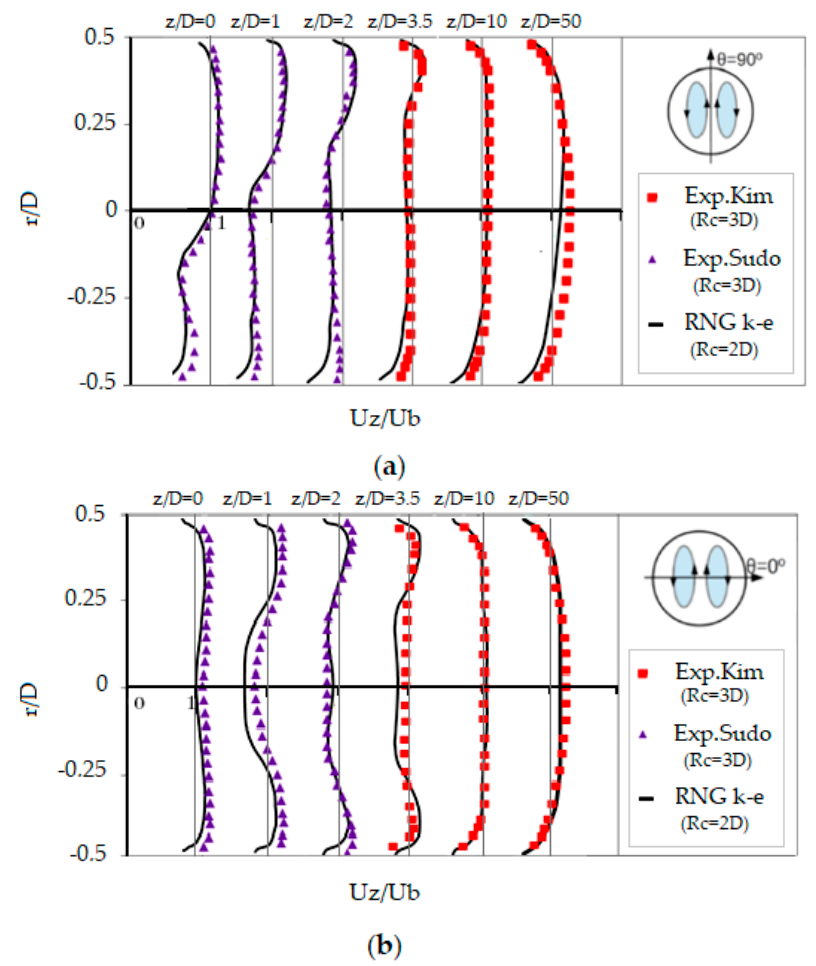
Figure 3. Longitudinal flow velocity comparisons at z/D = 0, z/D = 1, z/D = 2, z/D = 3.5, z/D = 10 and z/D = 50. ( a ) Vertical plane ( θ = 90°); ( b ) horizontal plane ( θ = 0°). Solid line: RNG k- ε turbulence model results. Experimental data from Sudo et al. (Re = 60,000) [10] and Kim et al. (Re = 50,800) [8].